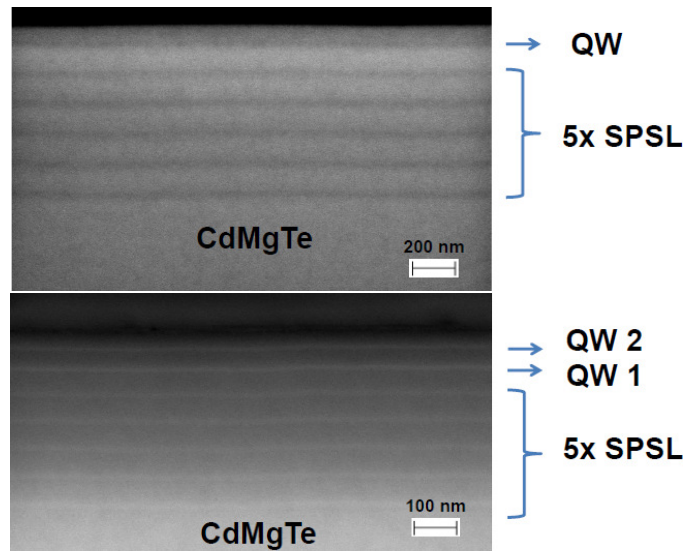
Figure 1. SEM photographs of the layered structure of the wafer A with one QW ( top ) and the wafer B with two QWs ( bottom